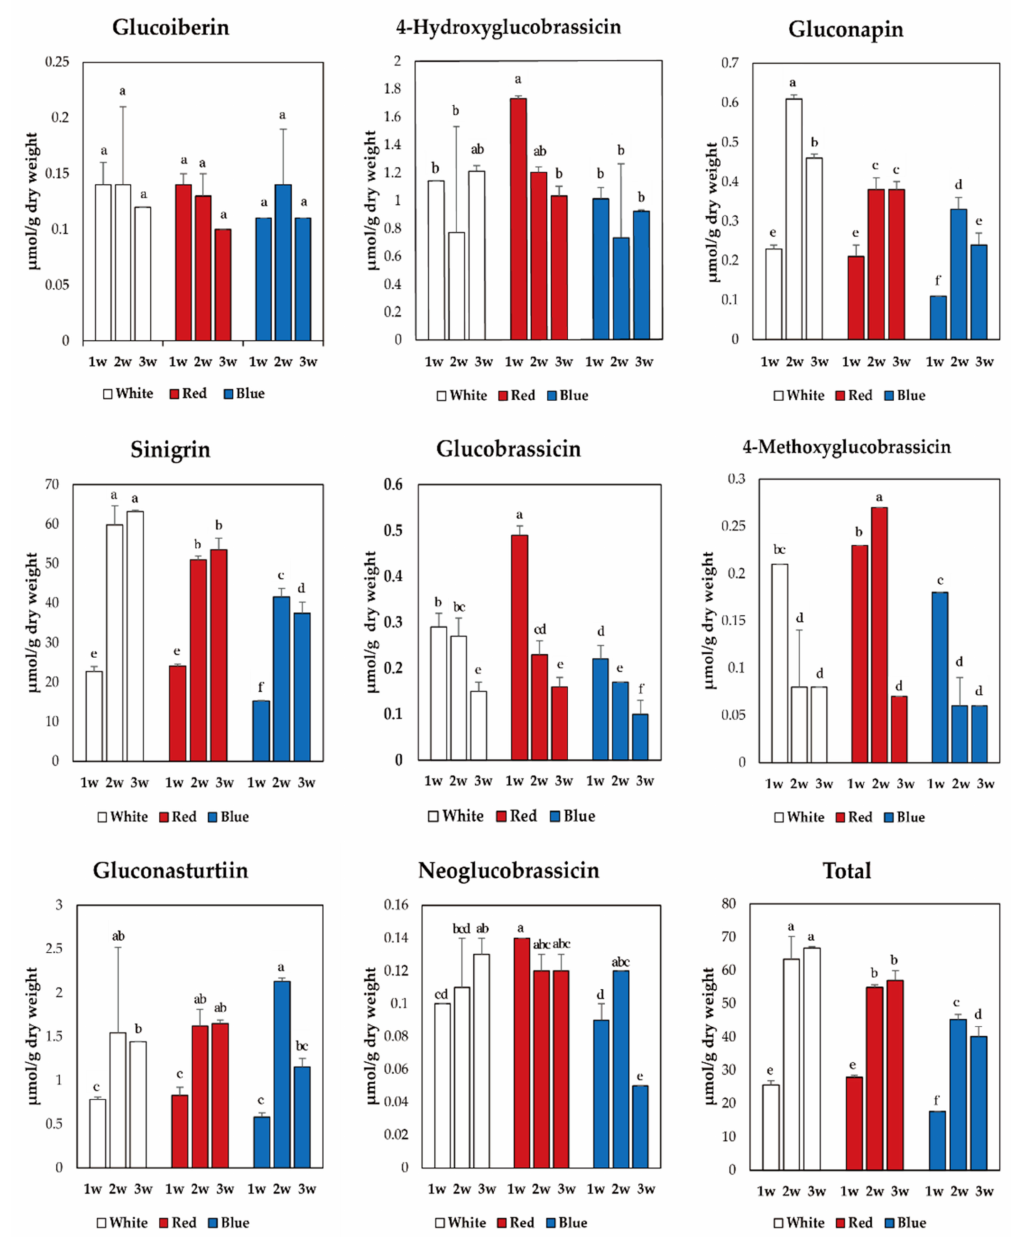
Figure 2. Glucosinolate contents of B. juncea sprouts grown under LED illumination of varying duration. Di ff erent letters indicate a significant di ff erence among means, applying Duncan’s multiple range test ( p < 0.05), and bars represent standard deviation of the mean. 1w, 2w, 3w indicate 1 week, 2 weeks, and 3 weeks,